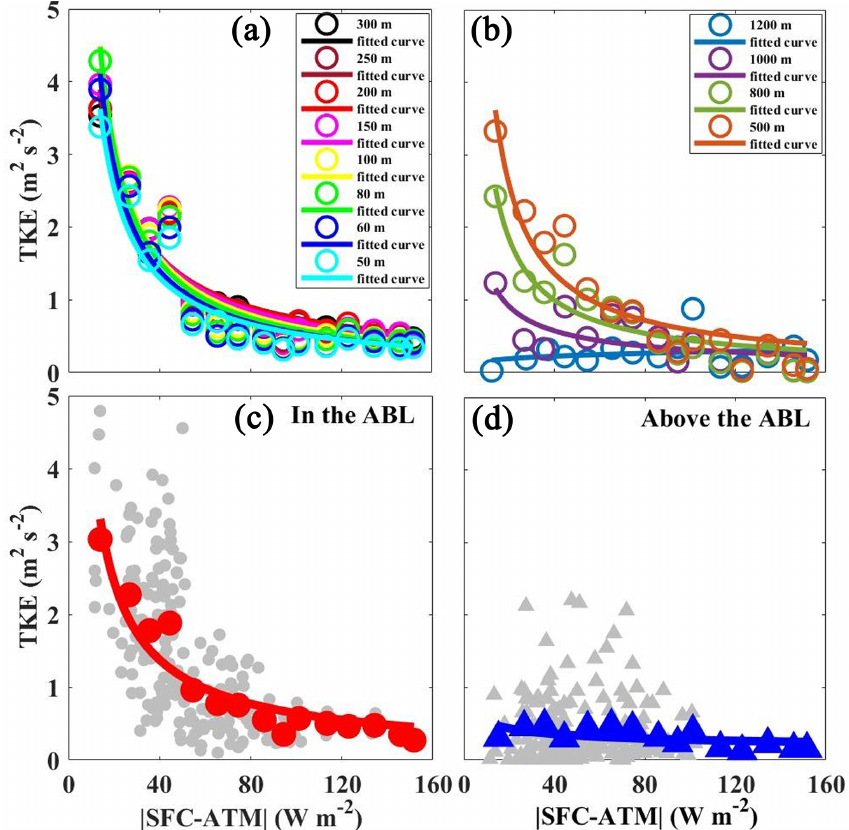
Figure 6. Scatterplots of the mean absolute difference in the aerosol radiative forcing at the surface and interior of the atmospheric column ( | SFC − ATM | ; x ) versus the mean turbulence kinetic energy (TKE; y ) at the different altitudes (a, b) . Scatterplots of | SFC − ATM | ( x ) versus TKE ( y ) in the ABL (c) and above the ABL (d) (gray dots: hourly data; other dots: mean data). The hourly data were collected over a 2-month period in Beijing from 27 November 2018 to 25 January 2019. (The hourly data mean hourly mean values of | SFC − ATM | and corresponding hourly TKE. The mean | SFC − ATM | was obtained by averaging hourly | SFC − ATM | at intervals of 10Wm − 2 , then the mean TKE was obtained after the average of the corresponding hourly